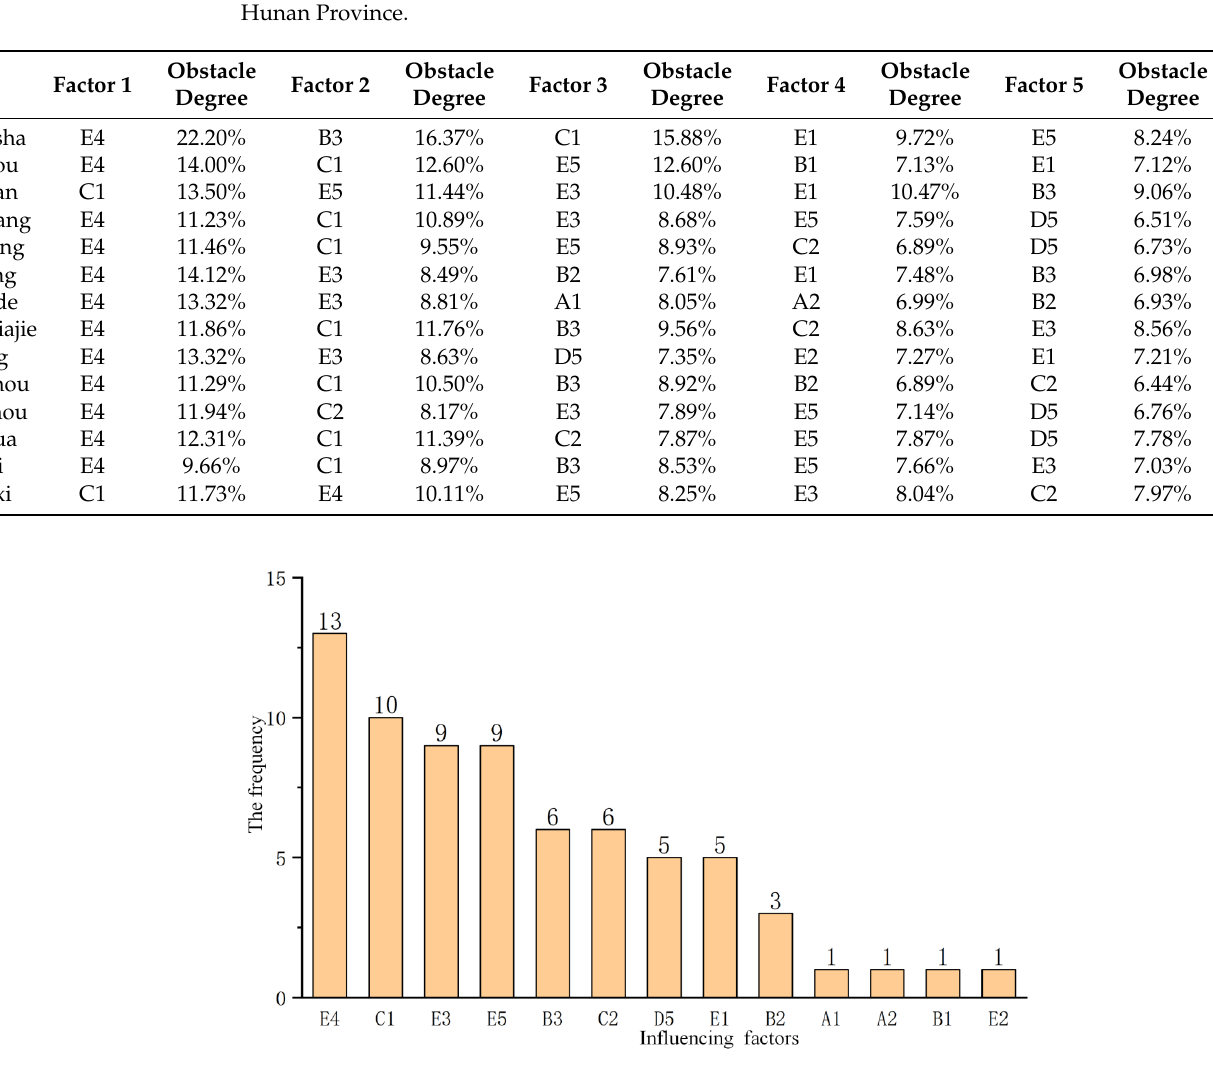
Figure 7. The frequency of main obstacle factors of each city in Hunan Province. Table 6. The main obstacle factors and the degree of obstruction in index layer of each city in Hunan Province.